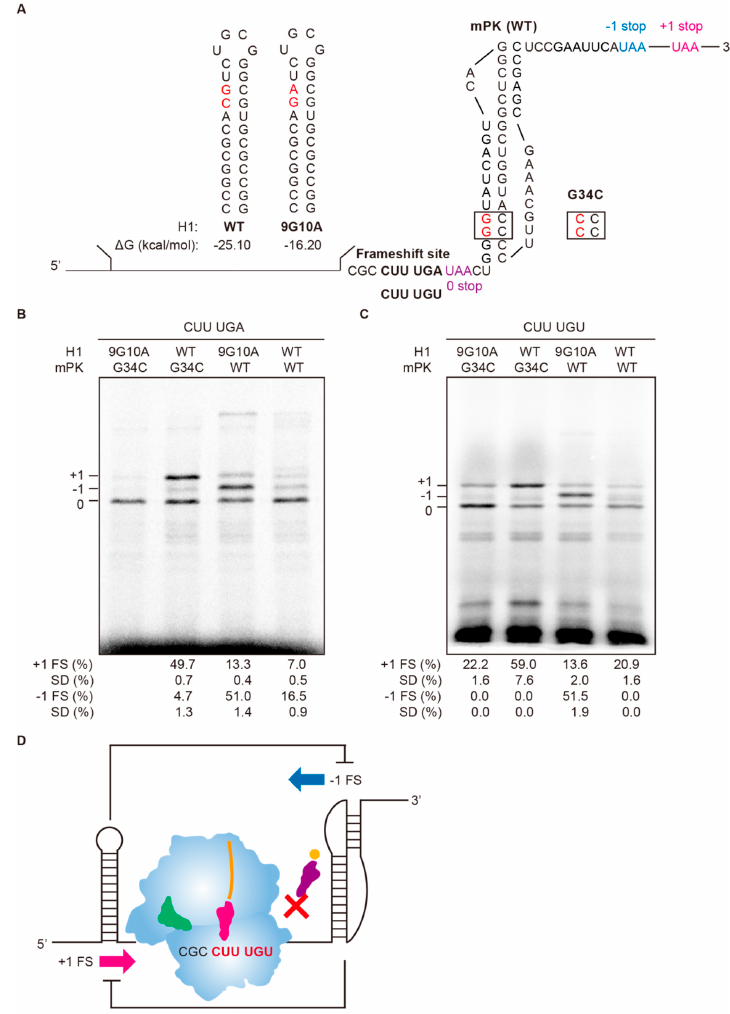
Figure 8. Bidirectional reading-frame switch regulation by structures flanking an empty A-site ribosome. ( A ) Partial sequences for reporter constructs inserted with CUUUGA frameshifting site and flanking structures of different stabilities. The A-site codon is UGA for RF2 exclusion frameshifting assay and is followed by a UAA 0-frame stop codon (colored in purple) to facilitate proper translation termination. The − 1 and +1 frame UAA stop codons (in colors) are located in the N-terminal region of Rluc ORF. Mutations to destabilize the upstream or downstream structures are shown in red. ( B ) SDS-PAGE analysis of radioactivity-based frameshifting assay using constructs in ( A ) in the absence of RF2. ( C ) SDS-PAGE analysis of in vitro radioactivity-based frameshifting assay using constructs with CUUUGU frameshifting site and different flanking structures compared with those in ( A ). The experiments were performed under conditions with UGU as a hungry codon (Figure S6). Calculated − 1 and +1 PRF efficiencies displayed are means ± SD of three independent experiments. ( D ) Scheme showing the opposite roles of flanking structures in bidirectional frameshifting regulation for an empty A-site